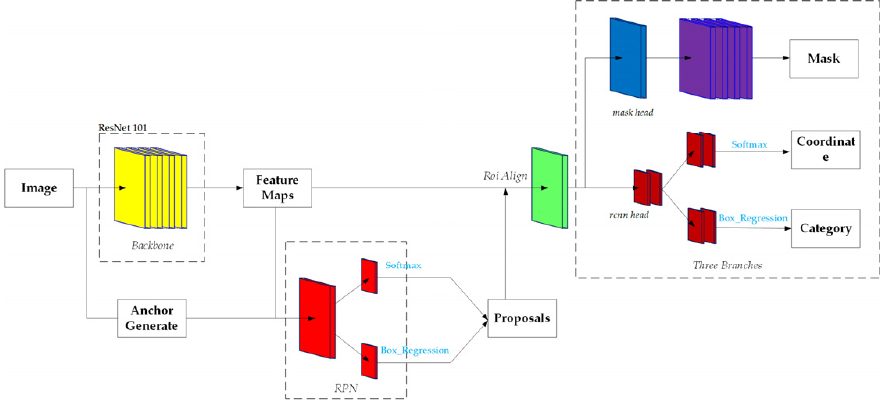
Figure 13. The structure of Mask Region Convolutional Neural Network (Mask-RCNN).